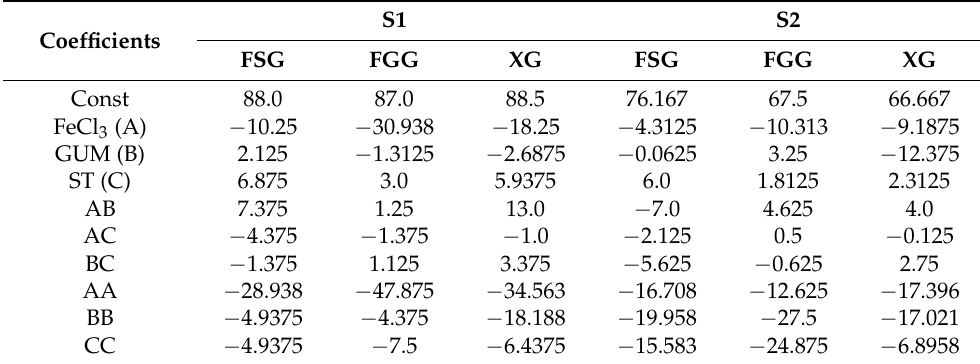
Table 2. Coefficients of the response function for arsenic removal (RE; %) at 295